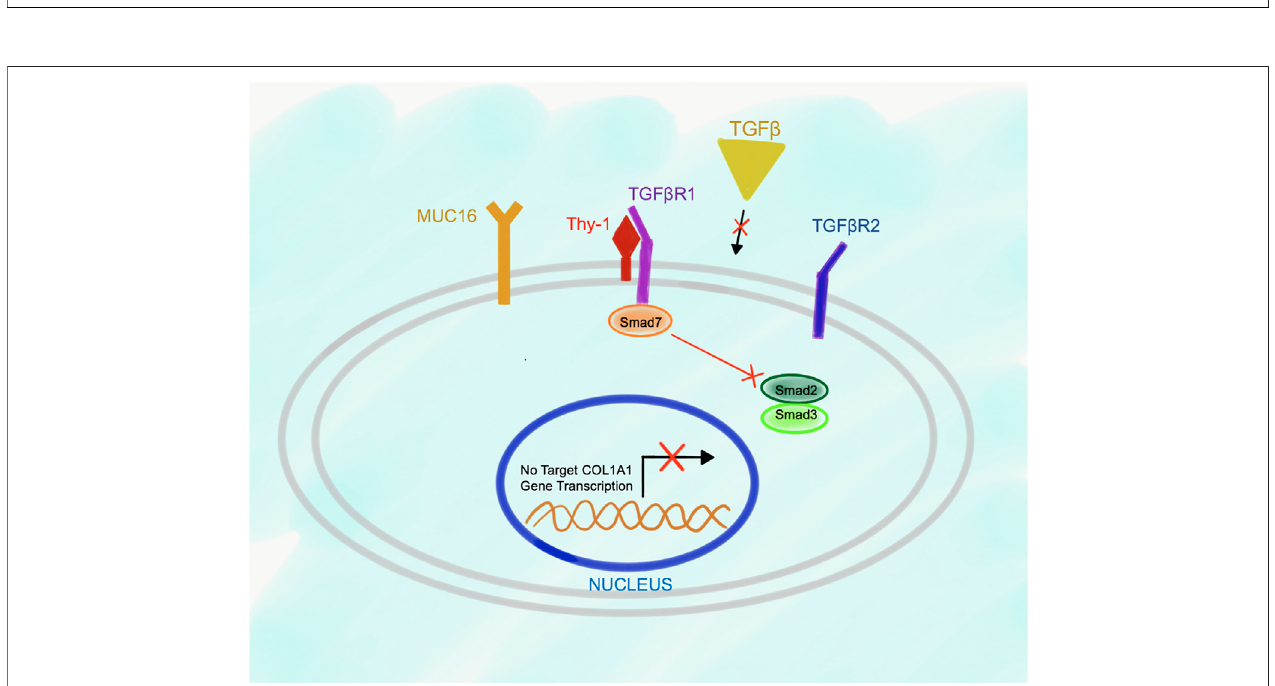
FIGURE 4 | Proposed model of Msln-Muc16-Thy-1-TGF β RI signaling in Msln -/- aPFs. TGF β 1 signaling is impaired in Msln -/- aPFs because Thy-1 forms a stable complex with TGF β RI, which hinders TGF β 1 binding to TGF β RI and TGF β R2. Smad7 is bound to the cytoplasmic tail of TGF β RI, thereby preventing docking and phosphorylation of